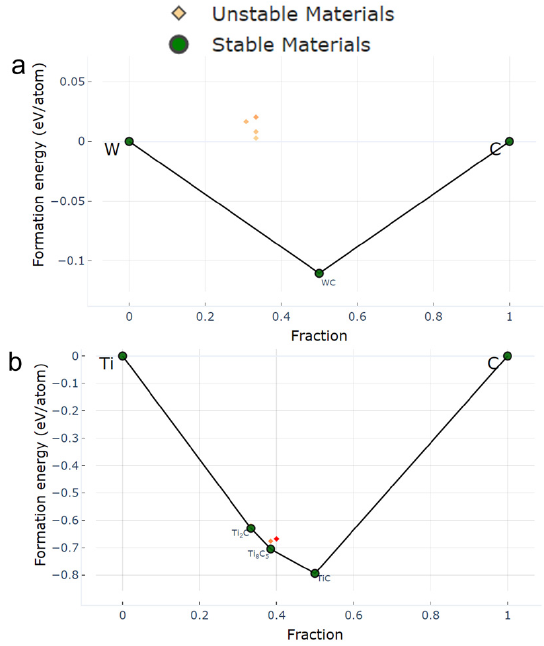
Figure 10. Interface reaction diagrams for systems W–C ( a ) and Ti–C ( b ).